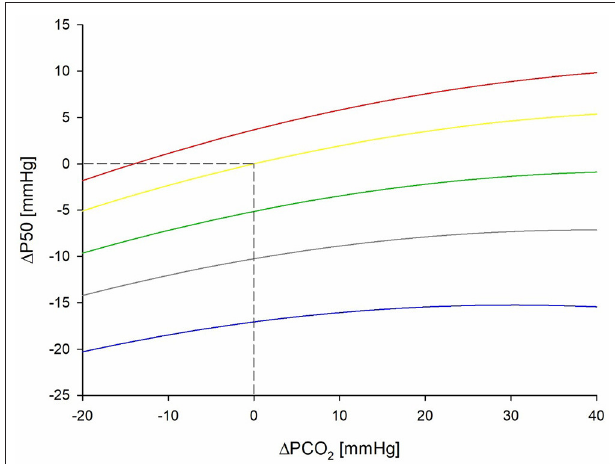
FIGURE 4 | Graphical presentation in form of a nomogram for the equation of 1 P50 dependency to 1 PCO 2 and different levels of temperature. 1 PCO 2 denotes difference from 40 mmHg (baseline PCO 2 ) and 1 P50 denotes difference from P50 at 37 ◦ C (baseline temperature) and 40 mmHg. Blue line represents 13.7 ◦ C, gray line 23 ◦ C, green line 30 ◦ C, yellow line 37 ◦ C, and red line 42 ◦ C. P50, oxygen partial pressure at which 50% of hemoglobin is saturated with oxygen; PCO 2 , carbon dioxide partial pressure.